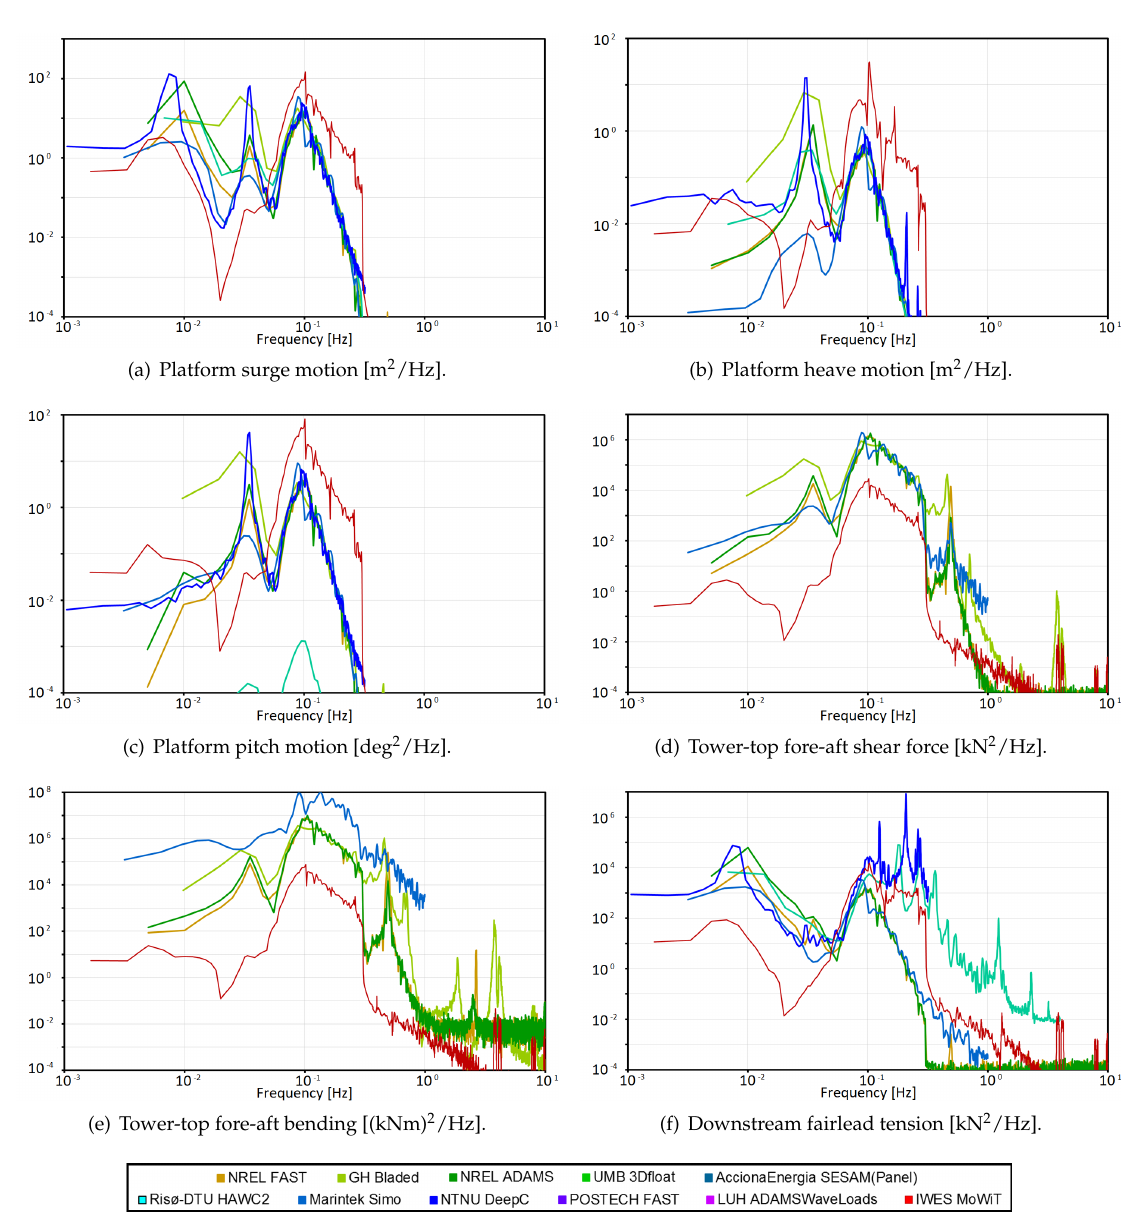
Figure 19. Hydro-elastic power spectra with irregular waves from LC 4.2, corrected for eliminating the deviations in the irregular wave